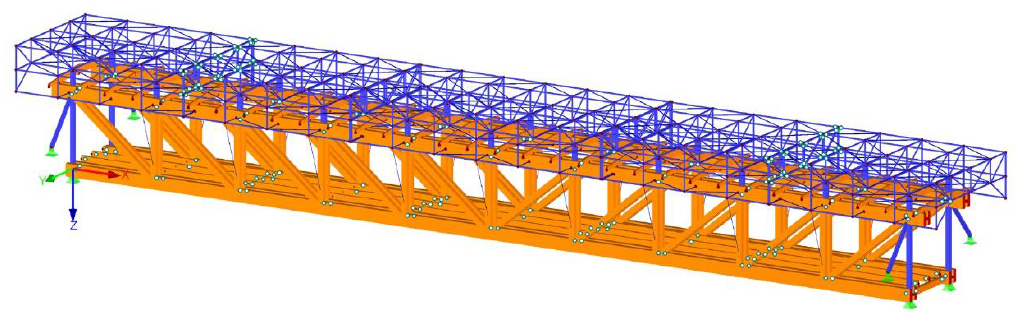
Figure 11. Three-dimensional model after the first update. Table 3. Results of the modal analysis after the first model update ( m eX , m eY , m eZ : translational